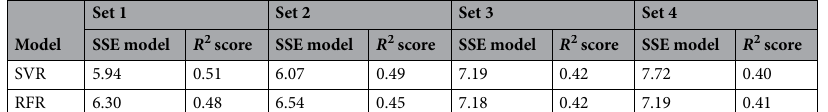
2 score for each